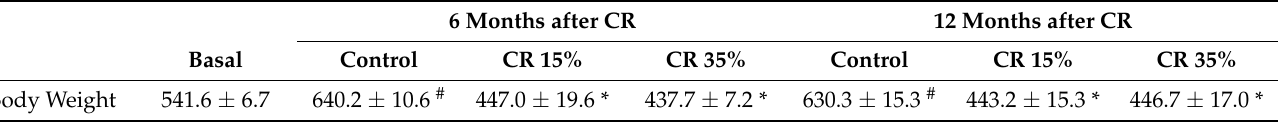
Table 1. Effect of CR on body weight in aged male Wistar rats.